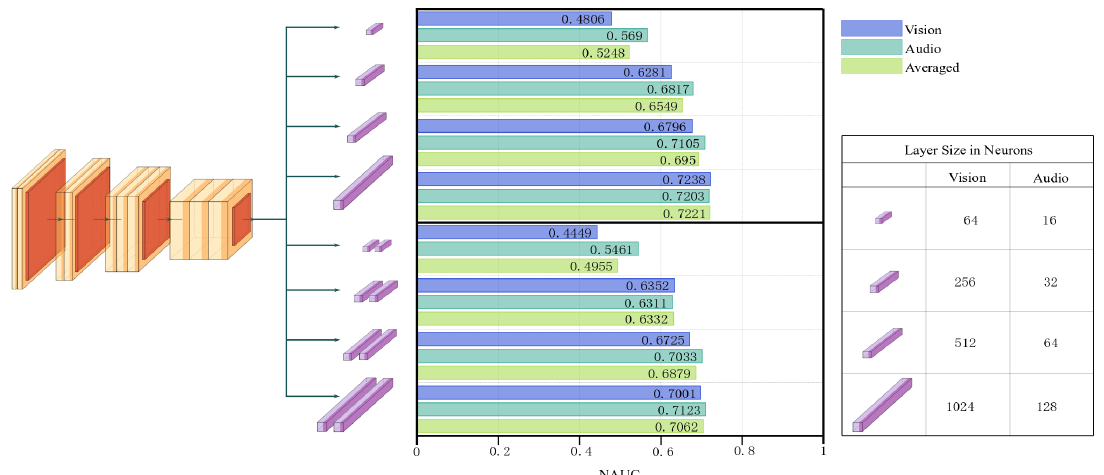
Figure 6. Sponge effect in vision and audio: Evidence for the increased sample efficiency of larger fully connected classifiers (“sponge effect”), shown by the averaged performance of eight different classifier designs on Vision and Audio